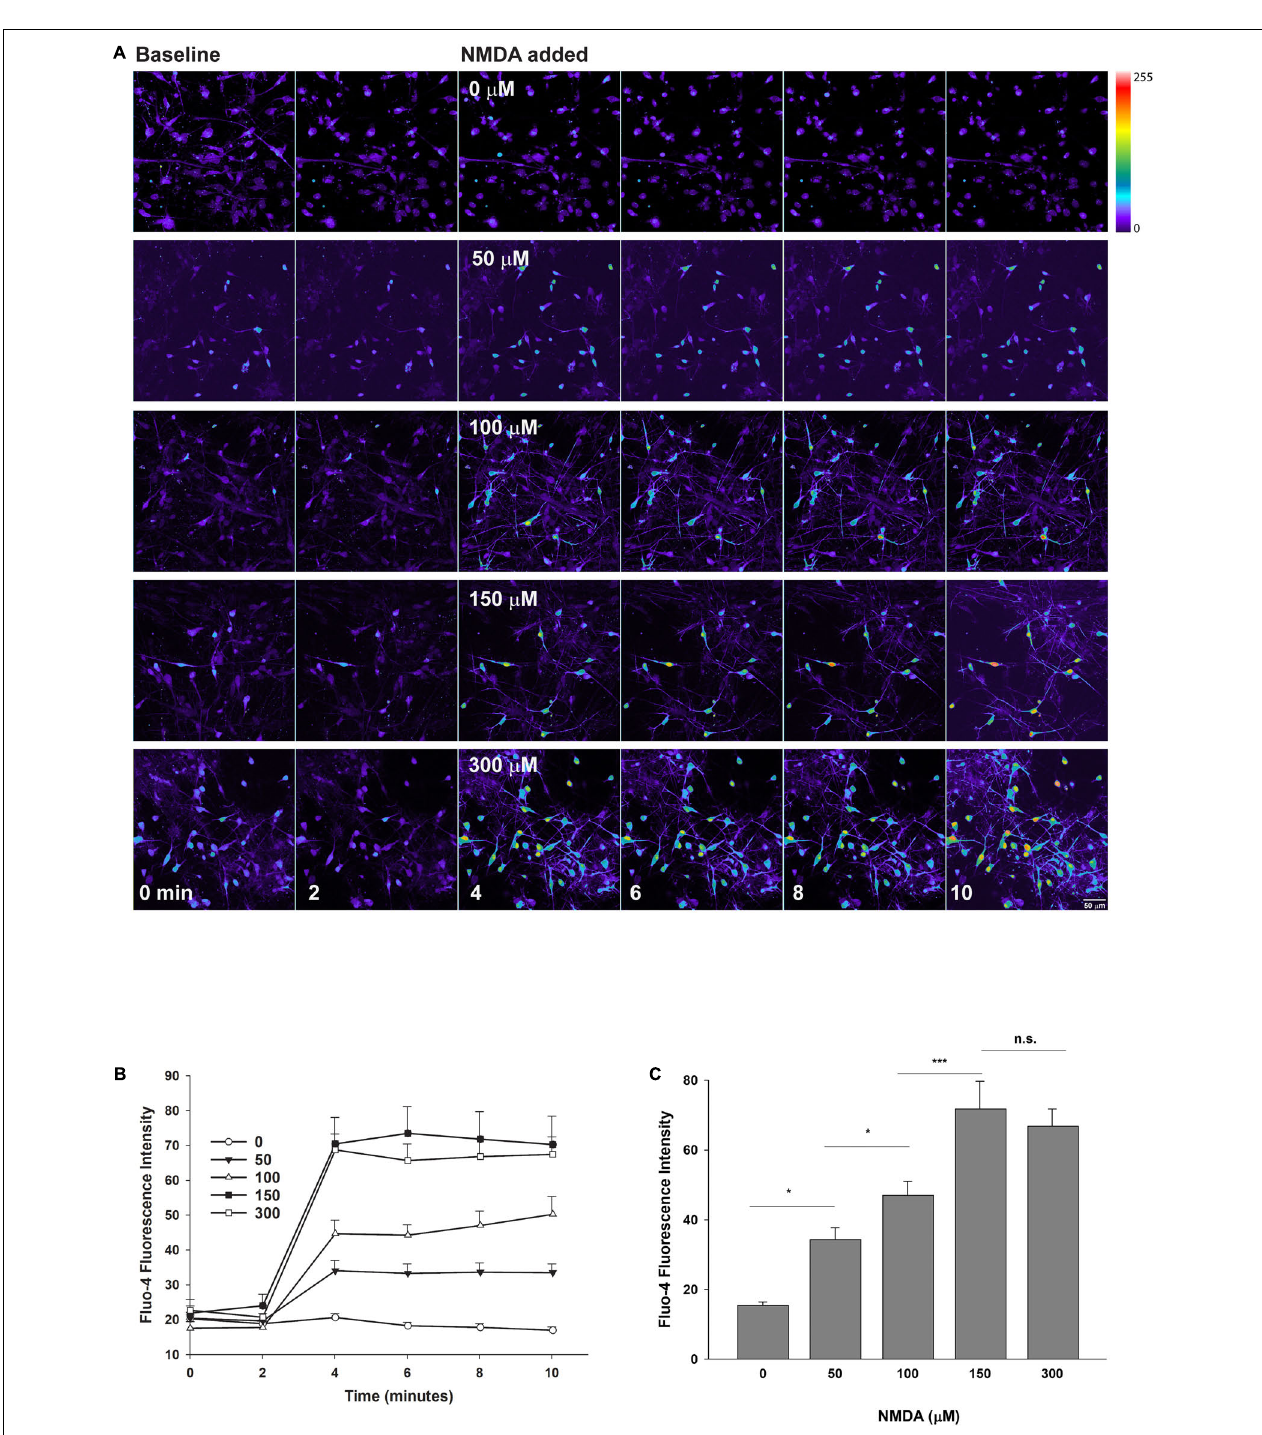
FIGURE 3 | Confocal imaging of intracellular calcium in human neurons exposed to NMDA. XCL-4 derived mature cultures (41–42 days in maturation media) were loaded with the calcium indicator Fluo-4 for 30 min and then washed with HBBSS 5 . 5 media, followed by the addition of glycine (final concentration of 100 µ M) prior to imaging. Using a time series protocol at 40 × magnification, images were taken every 2 min. Two baseline images were taken prior to the addition of vehicle (HBBSS 5 . 5 ), or increasing final concentrations of NMDA by bath application, and then four additional images were taken. (A) NMDA dose-response montages are shown. Images were converted to a linear pseudocolor scale using MetaMorph. Individual cells were identified and Fluo-4 fluorescence intensity at each time point was measured. The intensity of cells at each time point were averaged together. (B,C) Data were graphed using SigmaPlot 12 [full time series from one experiment (B) ; 10-min time point from five independent replicates (C) ] and one-way analysis of variance (ANOVA) and Holm-Sidak tests were performed for panel (C) using SigmaPlot 14.5. Data are represented as mean + SEM. *** P < 0.001; * P < 0.05; n.s., not significant. n = 32–74 cells per condition.